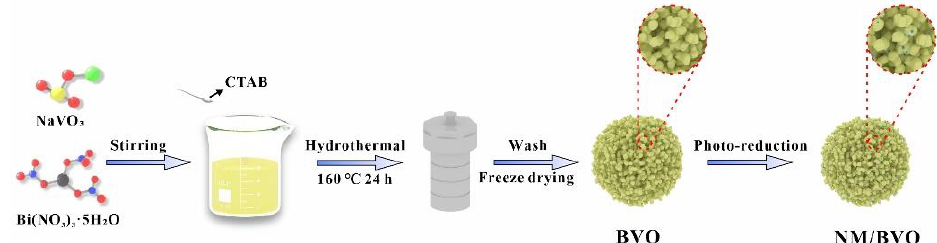
Figure 12. The schematic drawing showing the preparation procedure of NM-modified BVO.